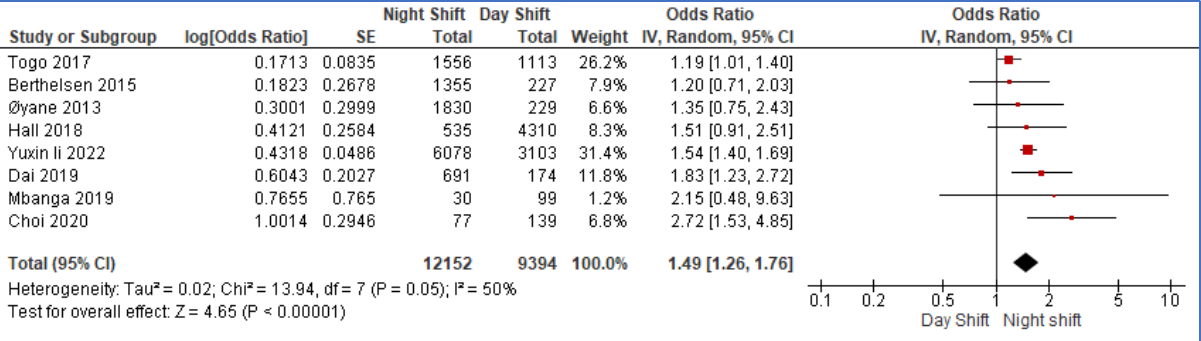
Figure 3. Forest plot of the summary of odds ratio of comparable studies [20,23–25,29,31,33,36].